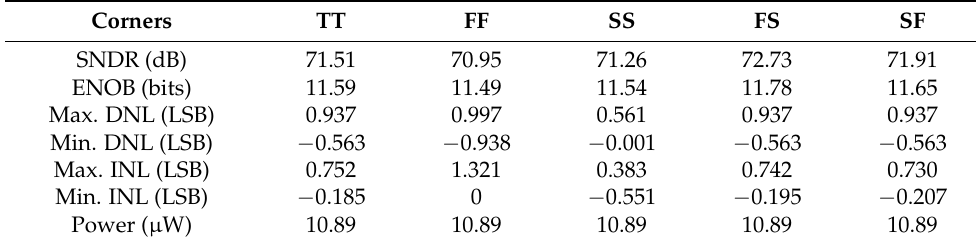
Table 2. Simulated results of the proposed S/H circuit with five design